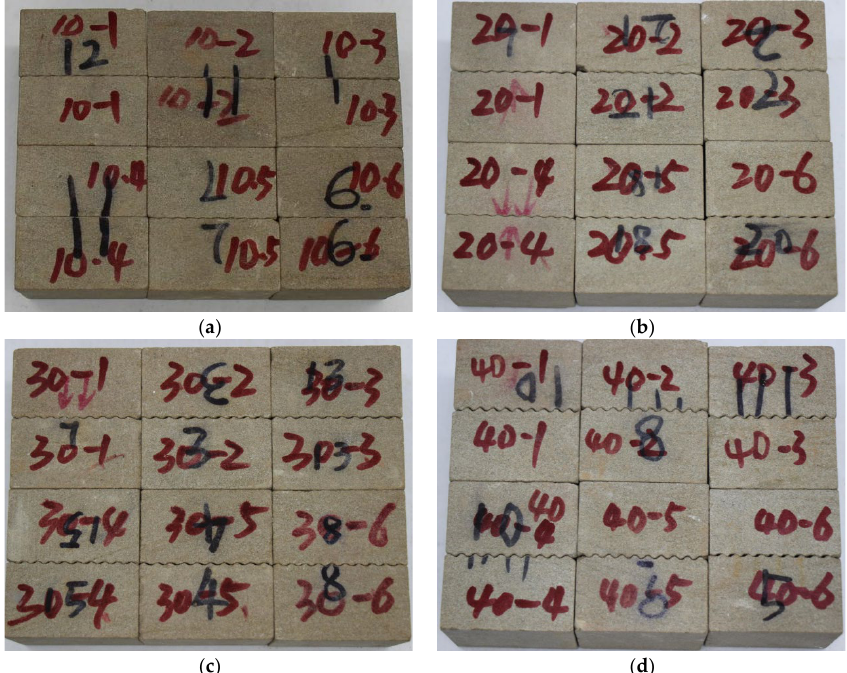
Figure 3. Summary of rock samples with different fluctuation characteristics. ( a ) Undulating angle of 10°; ( b ) Undulating angle of 20°; ( c ) Undulating angle of 30°; ( d ) Undulating angle of 40°.